Question: In one sentence, what is this figure communicating?
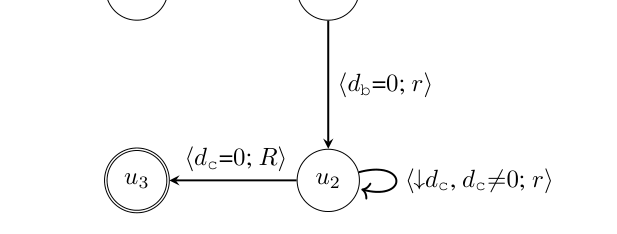
Answer: Numeric–Boolean reward machine with Boolean features ↓da, ↓db, ↓dc, da=0, db=0, and dc=0 for a sequential task a-b-c.